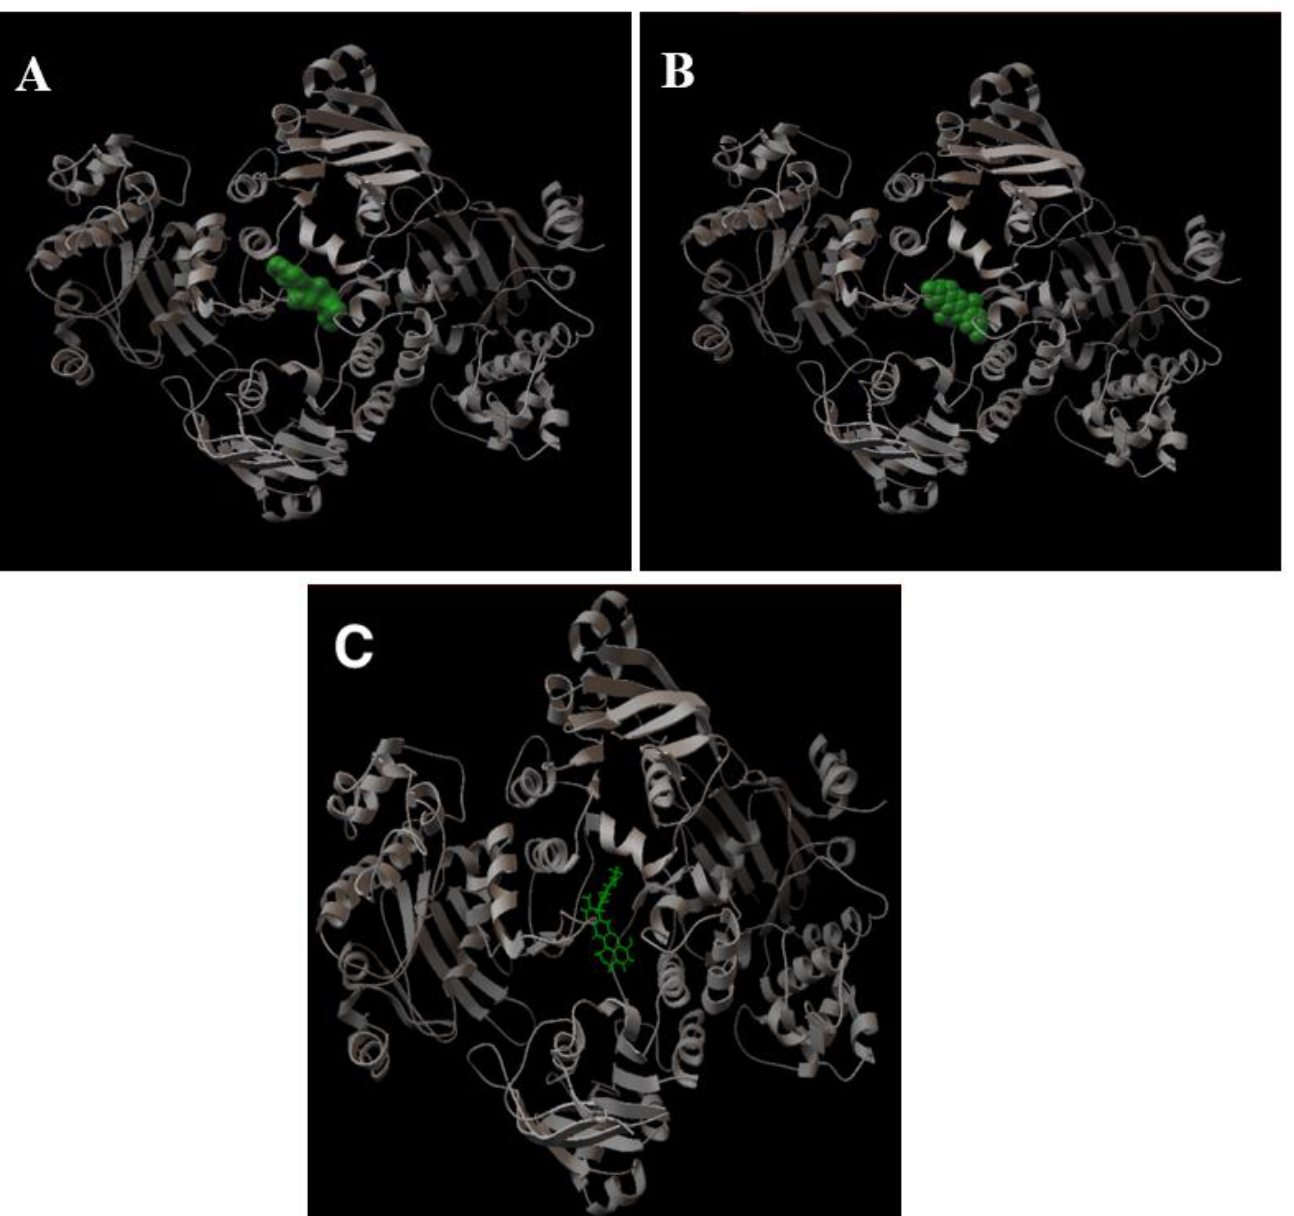
Figure 6. A 3D representation of the binding of verapamil, curine, and guattegaumerine on the LmrA protein. The pictures presented in the figure are a graphical output of AutoDock 4.2. All of the representations of LmrA (ribbon in gray) are in the same orientation. ( A ) Verapamil on LmrA; ( B ) curine on LmrA; ( C ) guattegaumerine on LmrA. Verapamil and curine are represented in terms of their volume (green) and guattegaumerine is shown in a stick